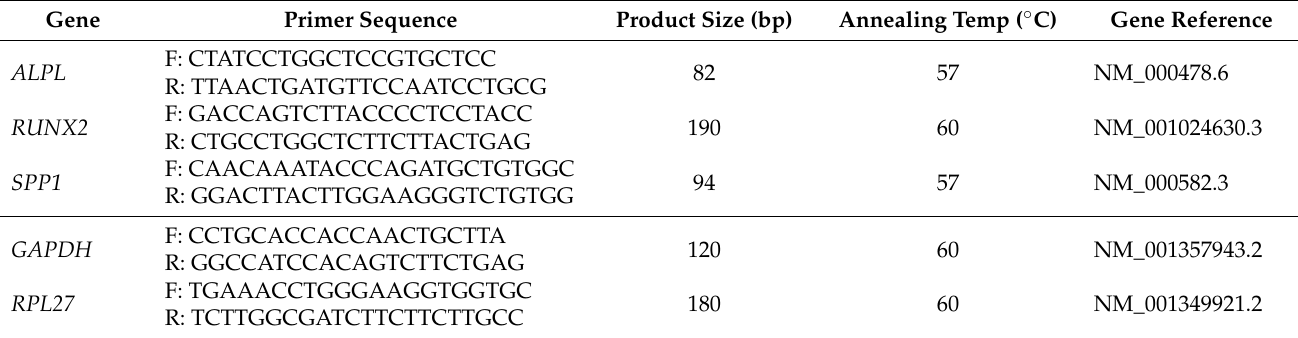
Table 1. Primer pairs used for